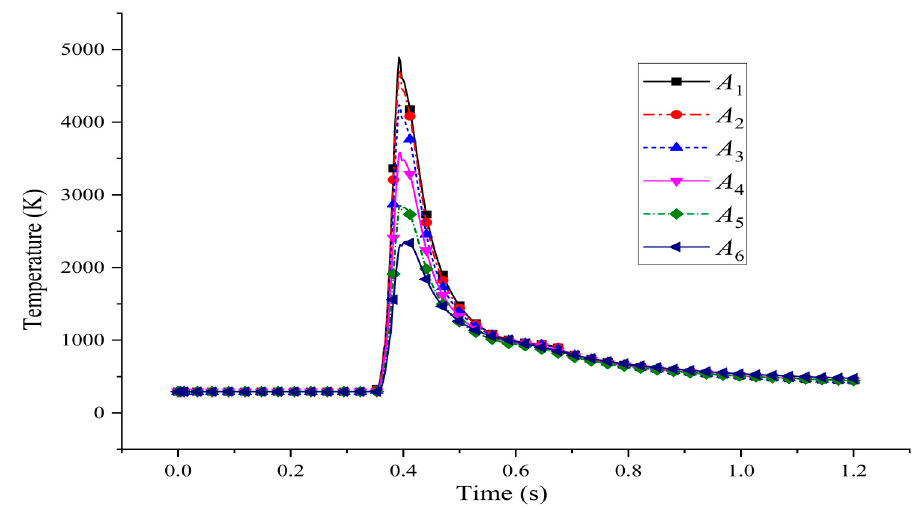
Figure 8. The thermal history of the sampling points on the AISI 304L side.